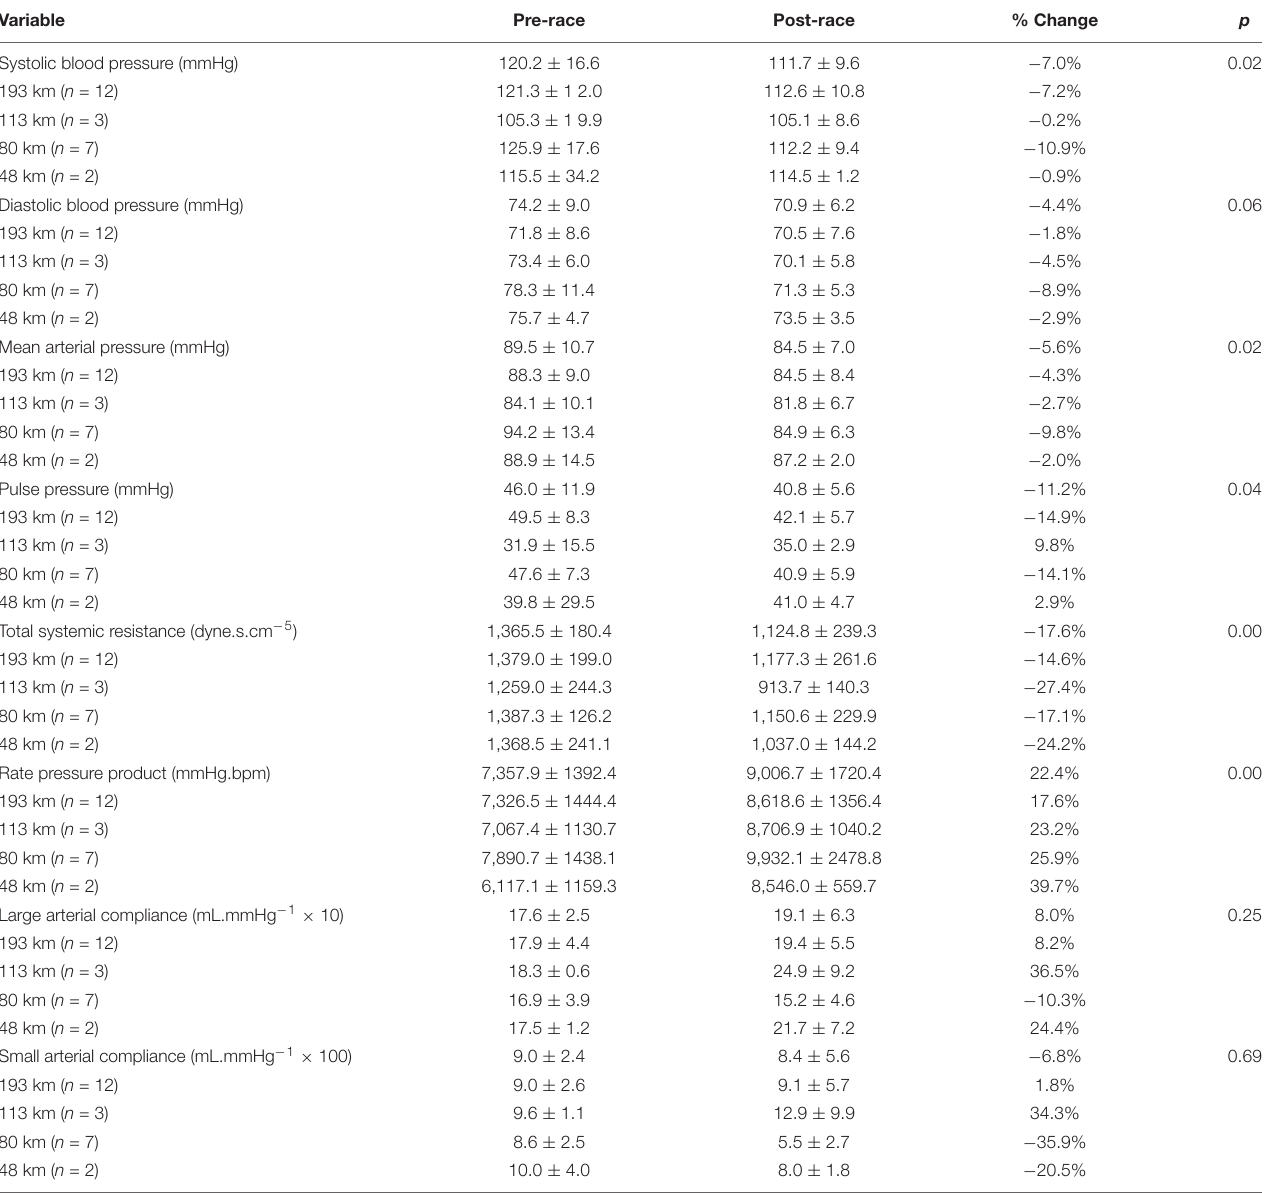
TABLE 3 | Pre- and post-race vascular function.